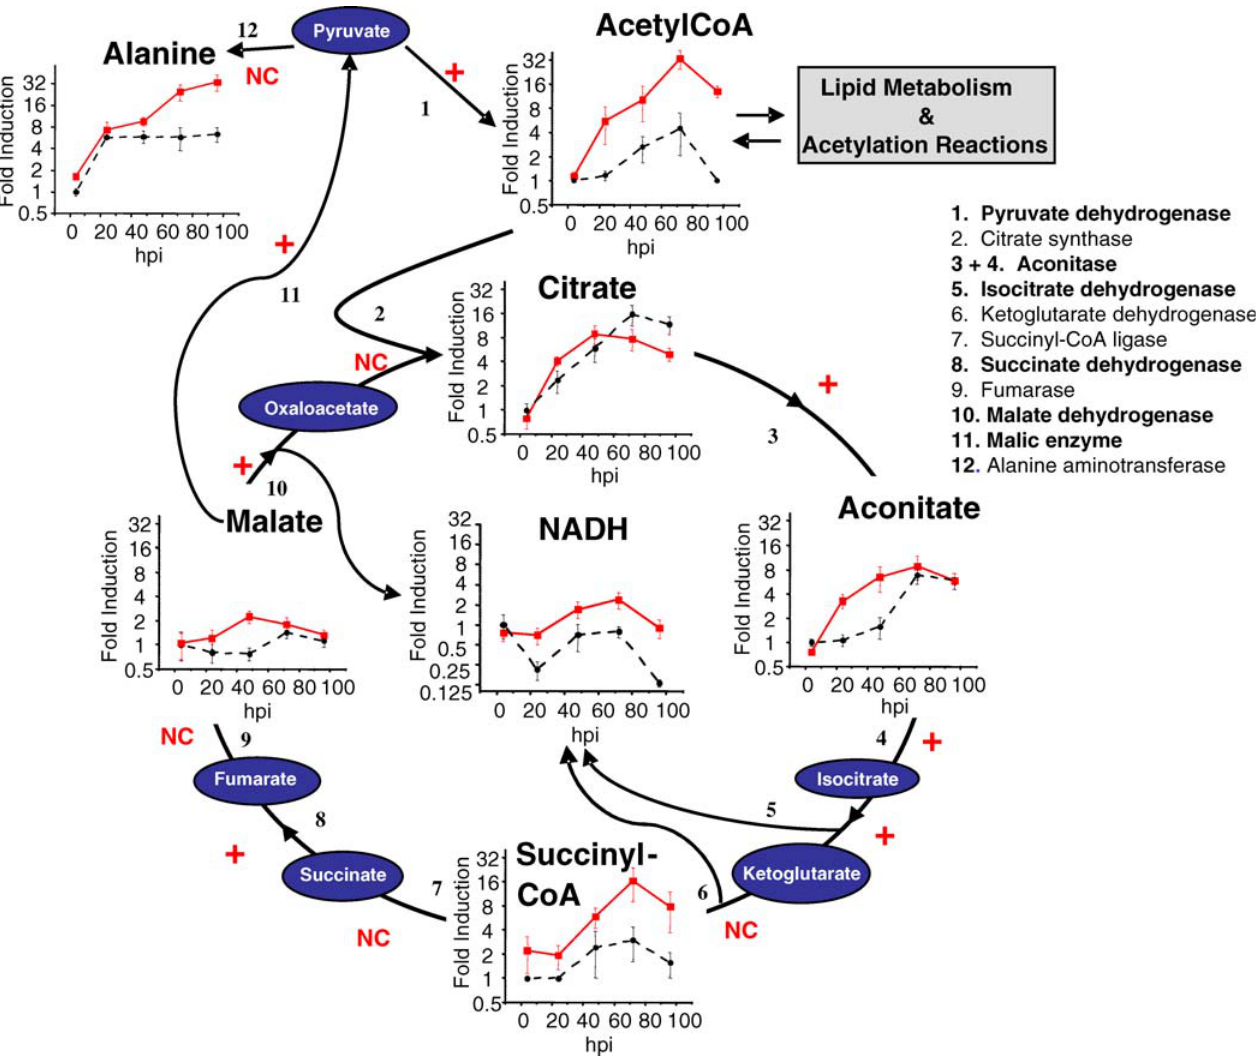
Figure 3. HCMV-Induced Changes in the TCA Cycle Metabolite data from mock-infected (dotted line) or virally infected (red line) fibroblasts are plotted, with the symbols þ and NC (shown in red) over the arrows indicating changing levels of enzyme transcripts as described in the Figure 1